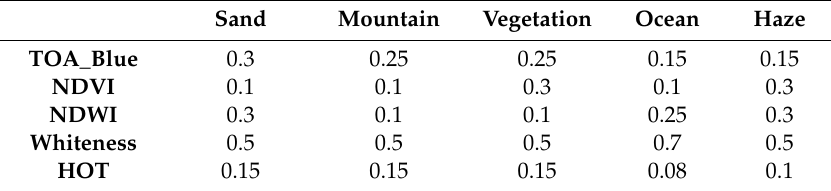
Table 11. The cloud detection thresholds for di ff erent surface types. Sand Mountain Vegetation Ocean Haze TOA_Blue 0.3